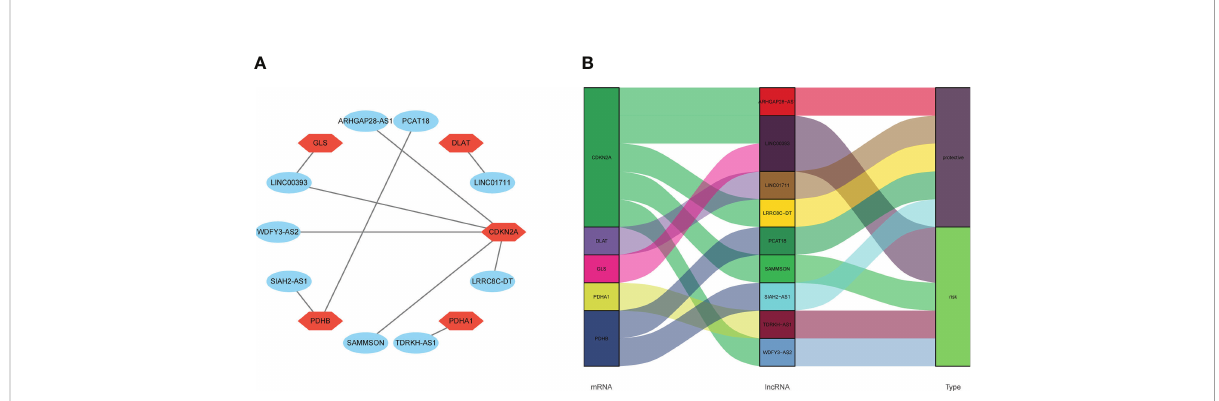
FIGURE 5 The relevance of cuproptosis lncRNAs and cuproptosis-related mRNAs. (A) Construction of a lncRNA – mRNA co-expression network. (B) The relationship among fi ve cuproptosis-related mRNAs, nine cuproptosis-related lncRNAs, and the risk types (risk or protective). lncRNA, long non- coding RNA.